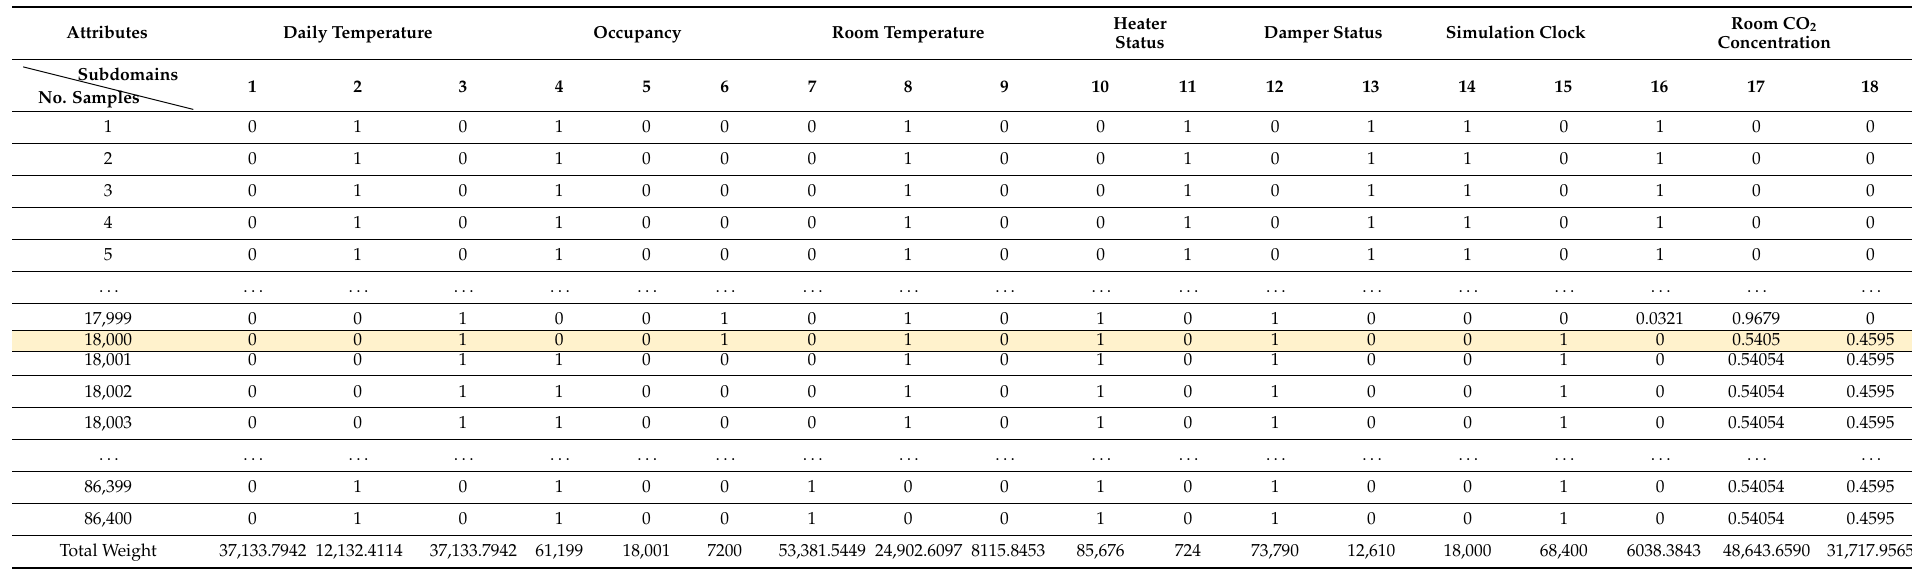
Table 15. Use-Case Weighted Fuzzy Relational Data Table for CO 2 Sensor Fault (The Background color shows the fault injection time